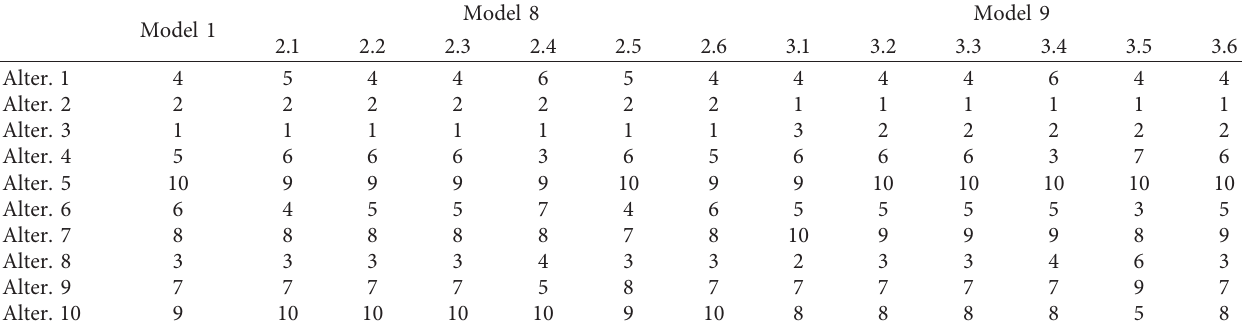
Table 18: Comparison of the ranks of alternatives according to models 1, 8, and 9.